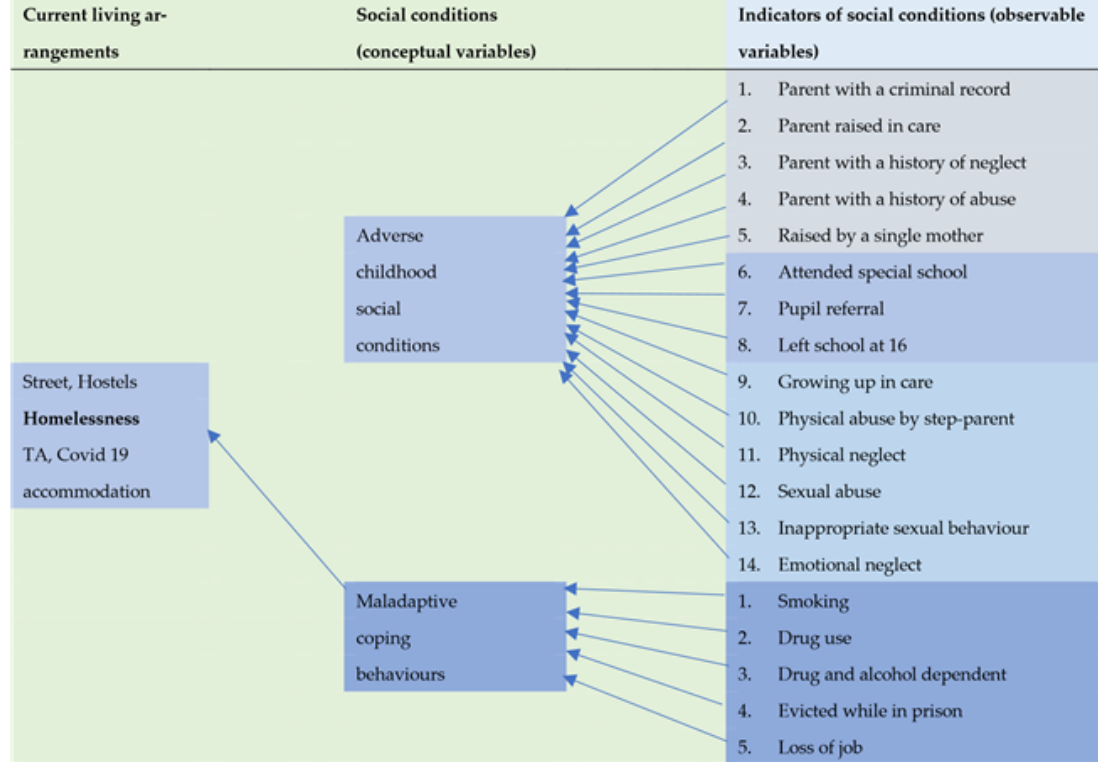
Figure 1. The current living arrangements, past social conditions, and indicators of social conditions (observable variables) relating to homeless people in the North West of England in